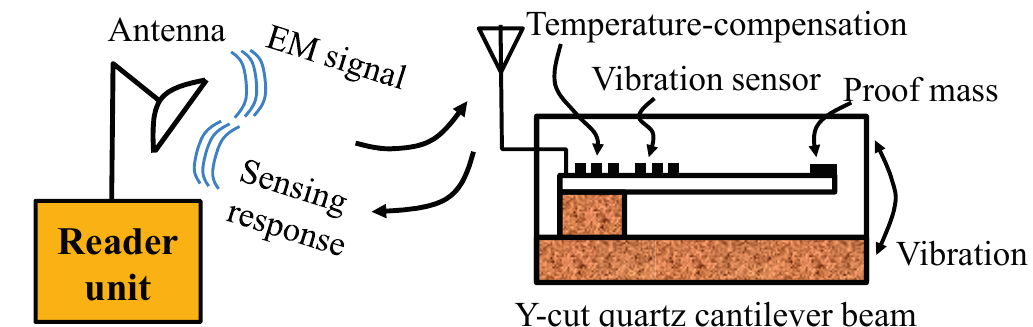
Figure 1. The schematic and principle of the wireless surface acoustic wave (SAW) vibration